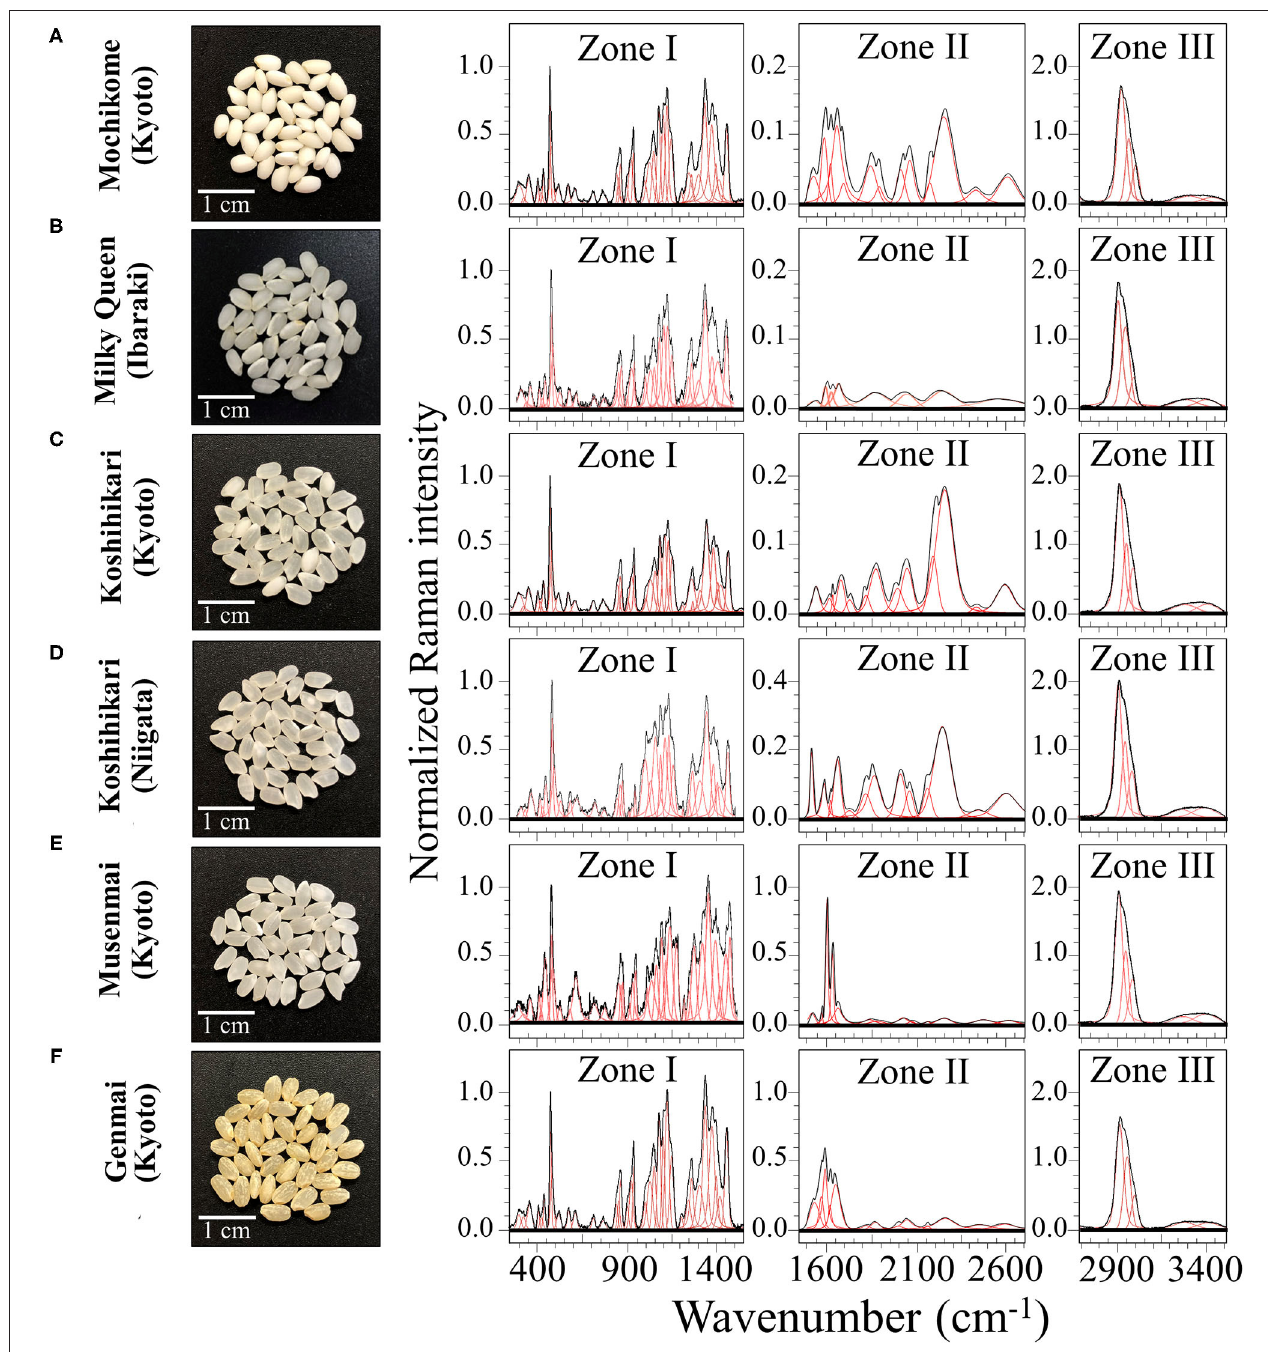
FIGURE 1 | Laser microscopy images of kernel cross sections from six different Japanese rice cultivars (A) Mochikome (Kyoto), (B) Milky Queen (Ibaraki), (C) Koshihikari (Kyoto), (D) Koshihikari (Niigata), (E) Musenmai (Kyoto), and (F) Genmai (Kyoto). Photographs of the kernels of six popular Japanese rice cultivars (cf. insets) and their related Raman spectra (divided into three separate spectral regions referred to as Zone I, II, and III at 250–1,500 cm − 1 , 1,500–2,700 cm − 1 , and 2,700–4,500 cm − 1 , respectively). Spectral deconvolution into Voigtian sub-bands is drawn with red lines.